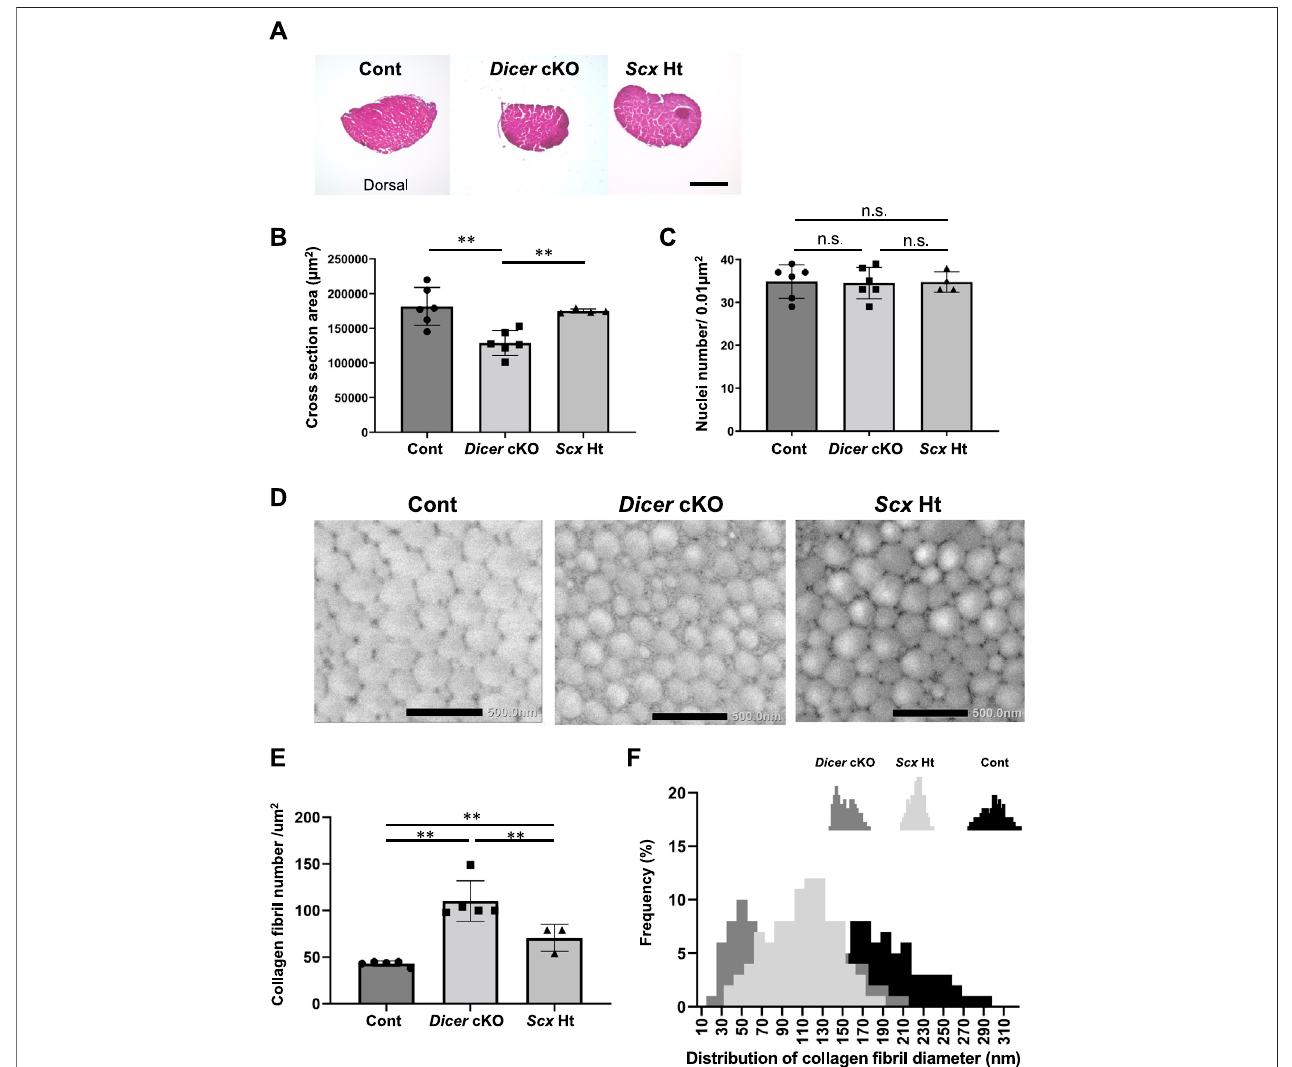
FIGURE 2 | Abnormal structure in Achilles tendon of Dicer cKO mice. (A) Hematoxylin and Eosin (H.E) staining of cross section of Achilles tendon in Cont, Dicer cKO,and Scx Htmiceat4 weeksofage. (B) Crosssectionarea(µm 2 )and (C) thenumberofnucleiperunitareaofasectionofAchillestendonat4 weeksofage( n =4 – 6 miceforeachgenotype). (D) Transmissionelectronmicroscopicviewofcollagen fi brilsinAchillestendonofCont, Dicer cKOand Scx Htmiceat10 weeksofage( n =3 – 5 mice for each genotype). Scale bars: 500 nm. (E) Collagen fi bril number per µm 2 was signi fi cantly increased in Dicer cKO mice compared with Cont and Scx